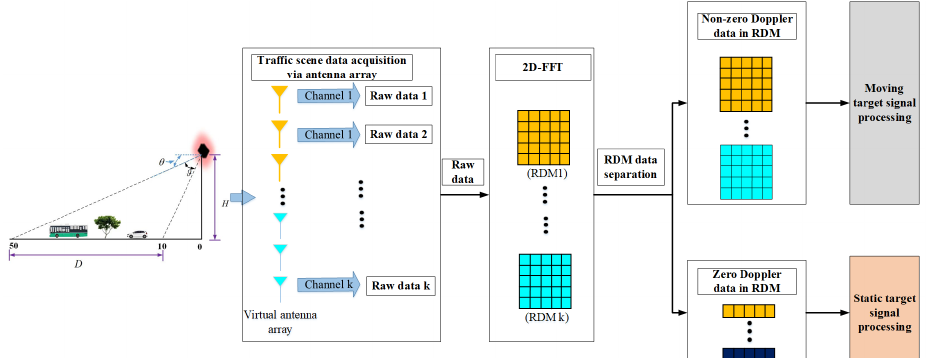
Figure A2. The radar signal pre-processing process.